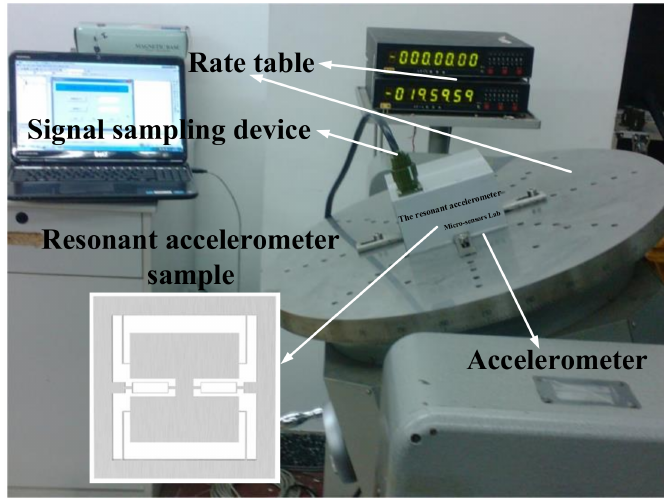
Figure 17. Schematic of the accelerometer 1 g tumbling